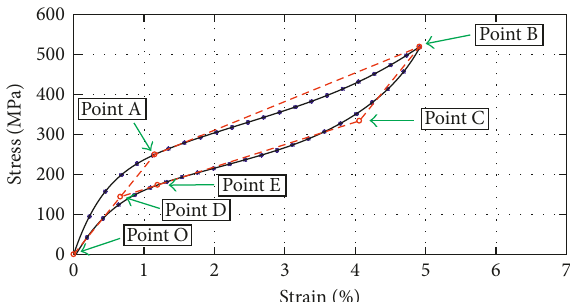
Figure 14: Derivation of simplified SMA material model from test data.